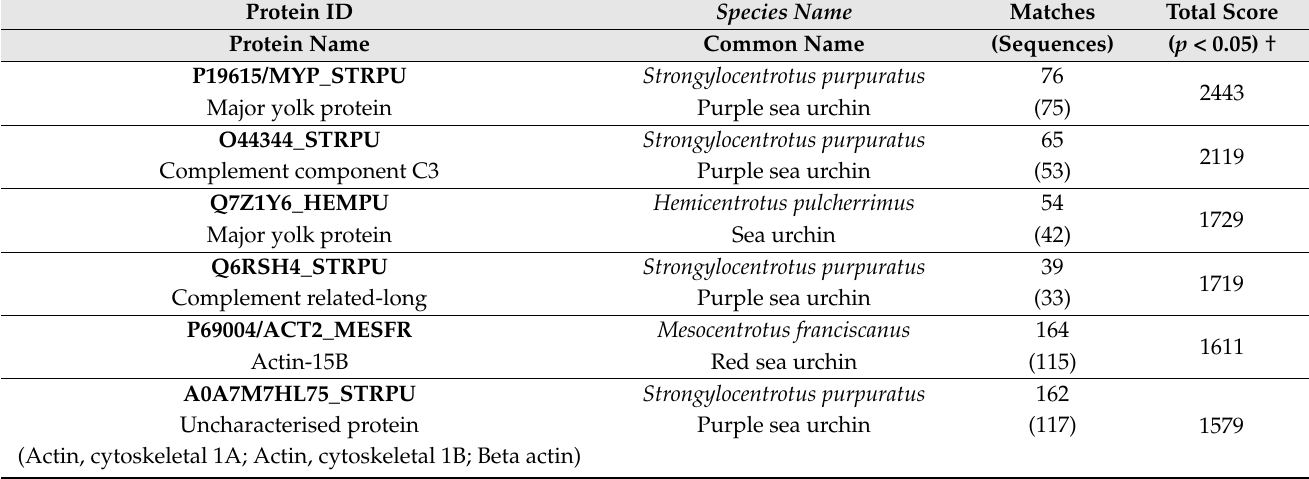
Table 1. Total protein cargo of coelomic fluid EVs from purple sea urchin ( Strongylocentrotus purpuratus ), identified by liquid chromatography with tandem mass spectrometry (LC-MS/MS) analysis. Uncharacterised hits with a secondary hit that was annotated are included and indicated in brackets; other unidentified protein hits are not included in this table but can be found in Supplementary Table S1, alongside detailed LC-MS/MS results (also including data from a common contaminant database; cRAP 20,190,401; 125 sequences; 41,129 residues). Protein ID, protein name, species hit with the Echinoidea UniProt database, number of matches, and total score are included in the table. The analysis is based on a pool of 3 individual